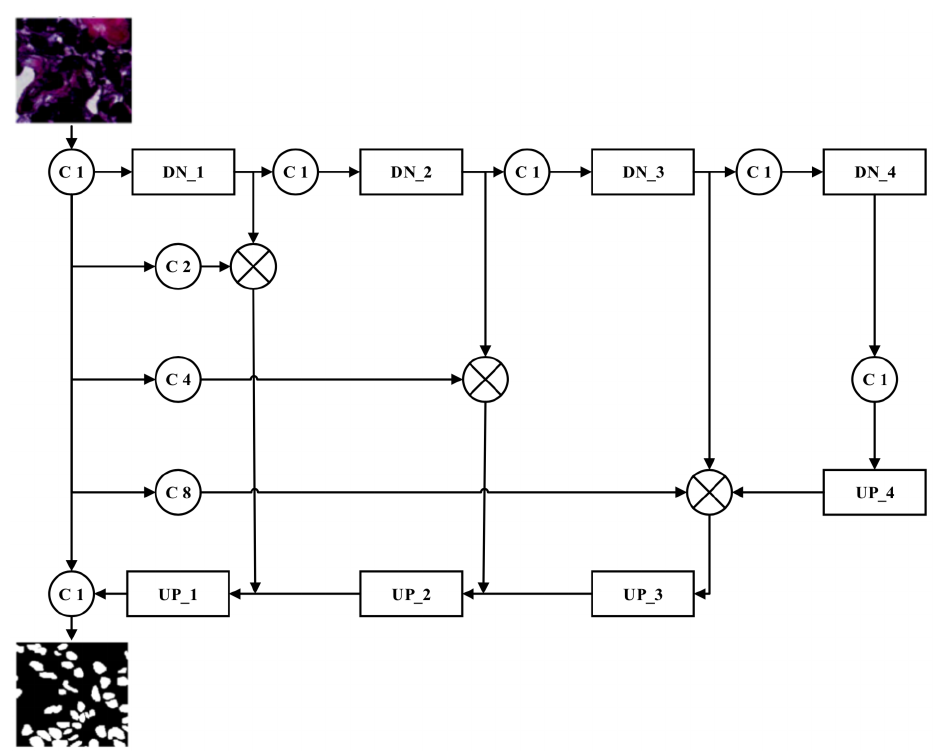
Figure 3. The architecture of convolutional blur attention